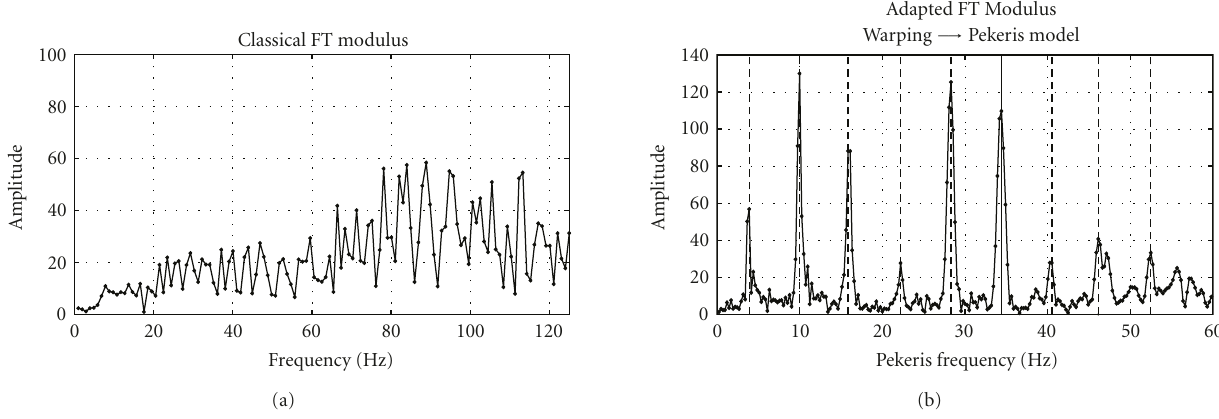
Figure 13: Classical Fourier spectrum and adapted Fourier spectrum of a signal recorded on a single hydrophone (the same as in Figure